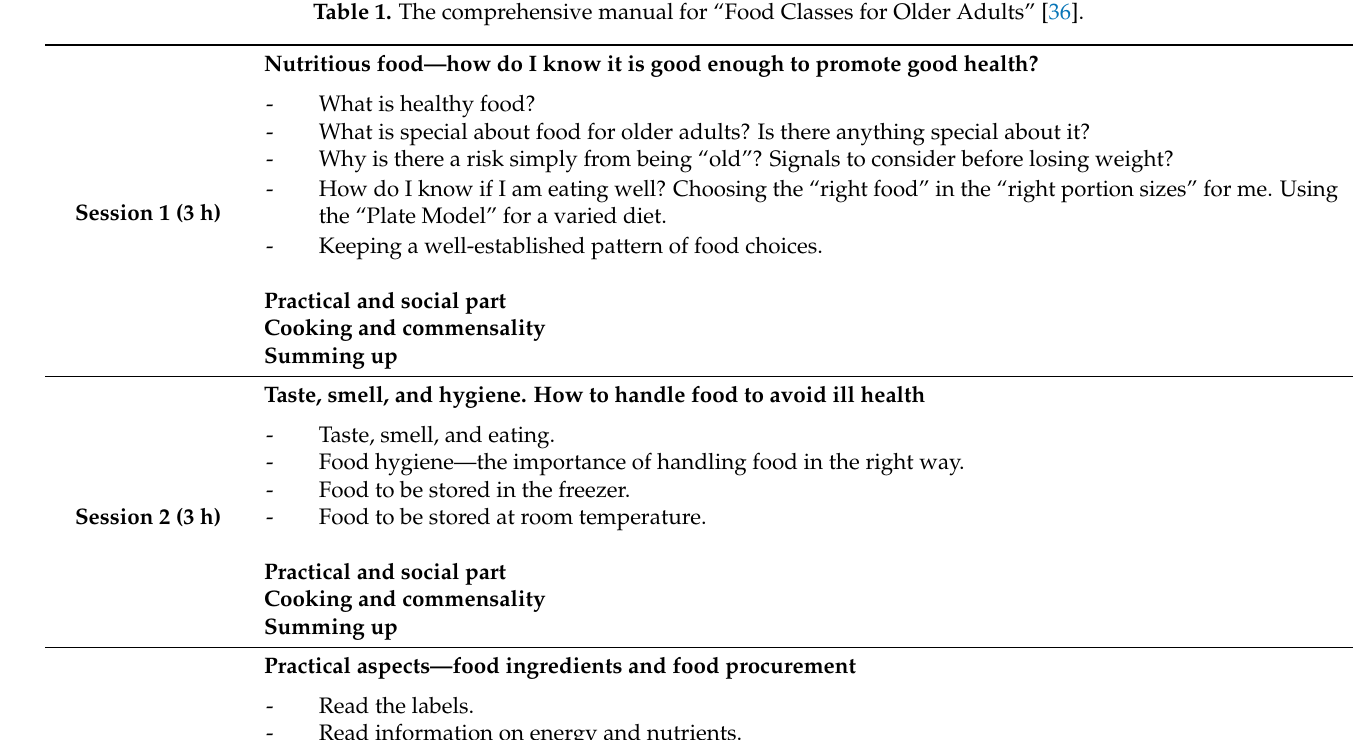
Table 1. The comprehensive manual for “Food Classes for Older Adults”